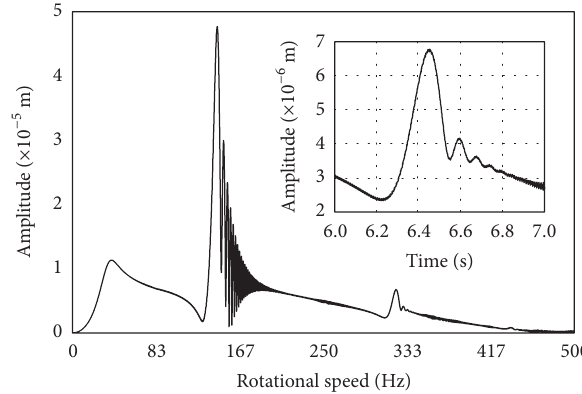
Figure 13: Total displacement at node 21 of the rotor-bearing system for the radial clearance of the squeeze film damper equal to 0.1905